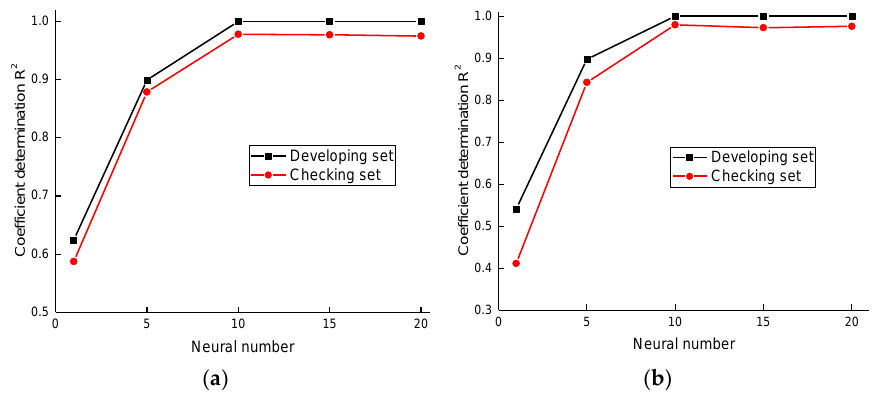
Figure 9. Robustness analysis of BRANN-FD models under varied hidden neuron numbers. ( a ) HW. ( b )